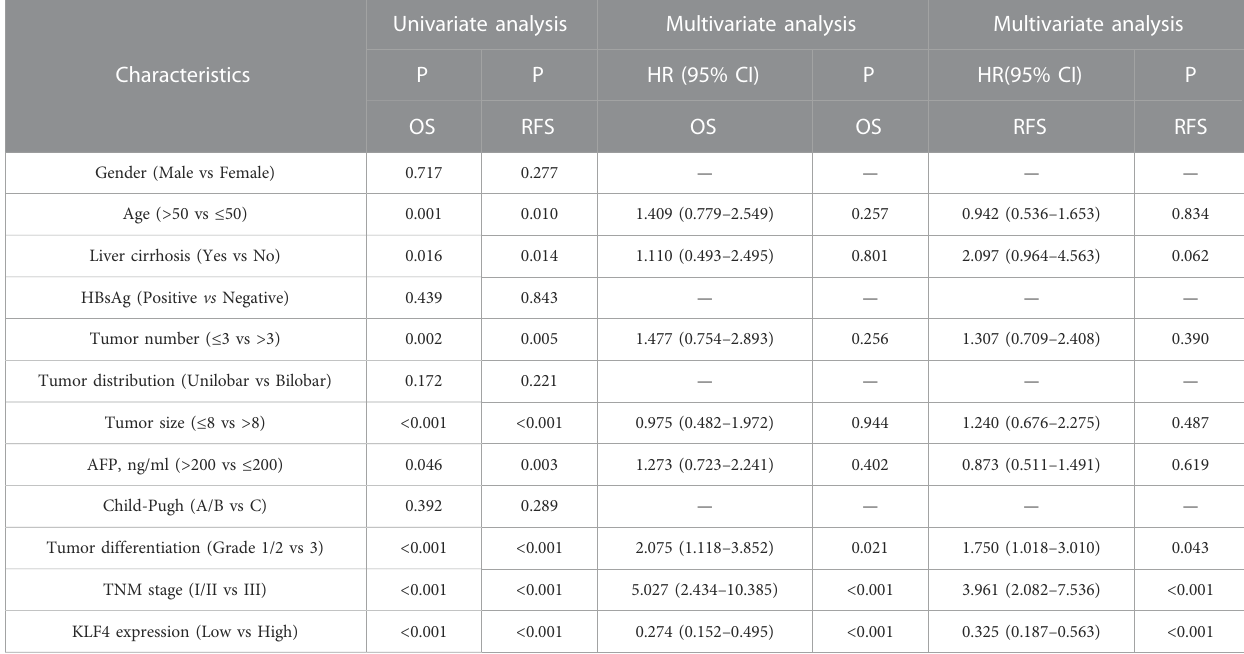
TABLE 2 The prediction for OS and RFS of 141 HCC patients with univariate and multivariate analyses. Univariate